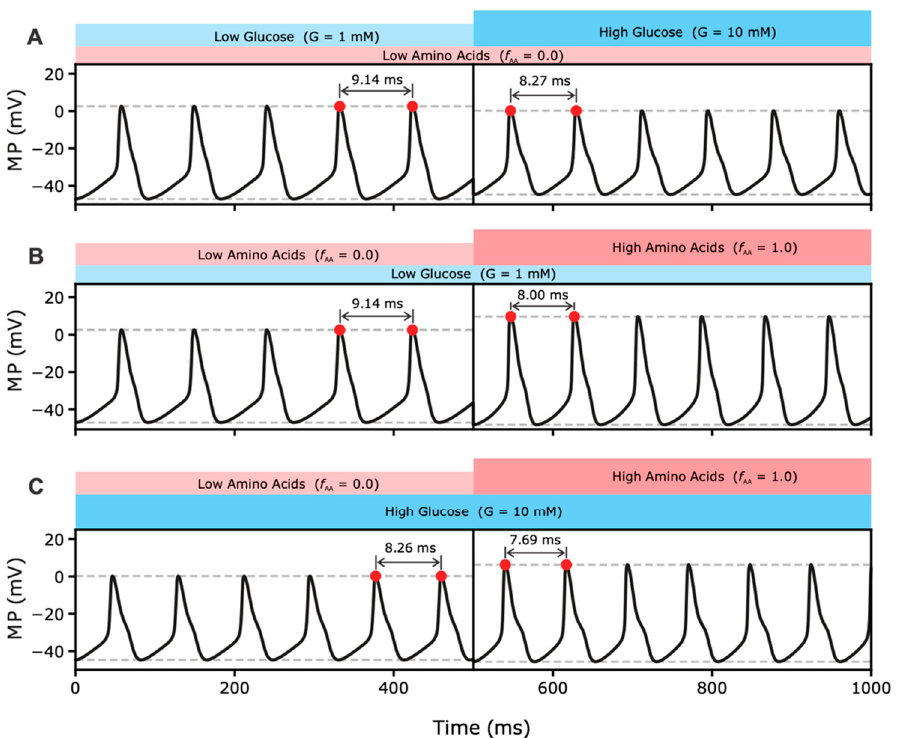
Figure 2. Dynamics of MP at different glucose and AA concentrations. ( A ) At high glucose con- centration, the amplitude of the MP oscillations decreases and the frequency increases. ( B ) At low glucose concentration, the increase in AA concentration increases both amplitude and frequency of MP oscillations. ( C ) At high glucose concentration, the increase in AA concentration increases both the amplitude and frequency, but the change is not as significant.